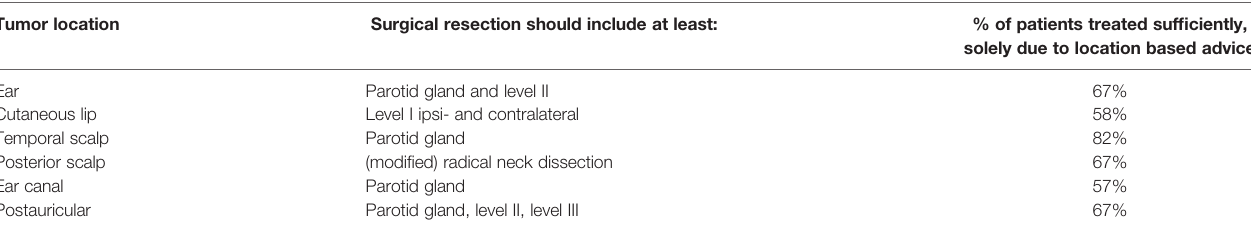
TABLE 4 | Lymph node levels (per tumor location) suggested to be minimally included in the surgical resection, regardless of pre-surgical imaging and diagnostics of the individual patient. Tumor location Surgical resection should include at least: